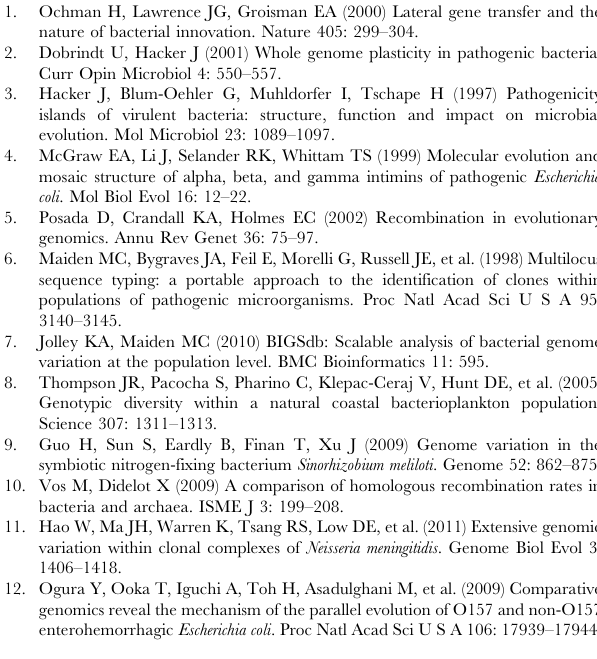
The phylogeny shows identical topological relationships as in Figure 2 for all but the O104 strains. (TIF) Figure S3 DNA distance of the second recombinant region in Figure 11. DNA distance was measured against the W strain. (TIF) Figure S4 Dot plot of related pAA plasmid genomes. The likely relationship of corresponding chromosomes is shown on the top, and currently there is no complete chromosome sequence associated with pO86A. (TIF) Figure S5 BRIG analysis of pAA plasmid genomes using the pAA plasmid in ON2011 as the query sequence. (TIF) Figure S6 DNA distance among related plasmid ge- nomes. Non-overlapped 500-nucleotide fragments from the second plasmid in ON2011 were used as query sequences. Each data point is based on the DNA distance between the query and subject sequence alignment.